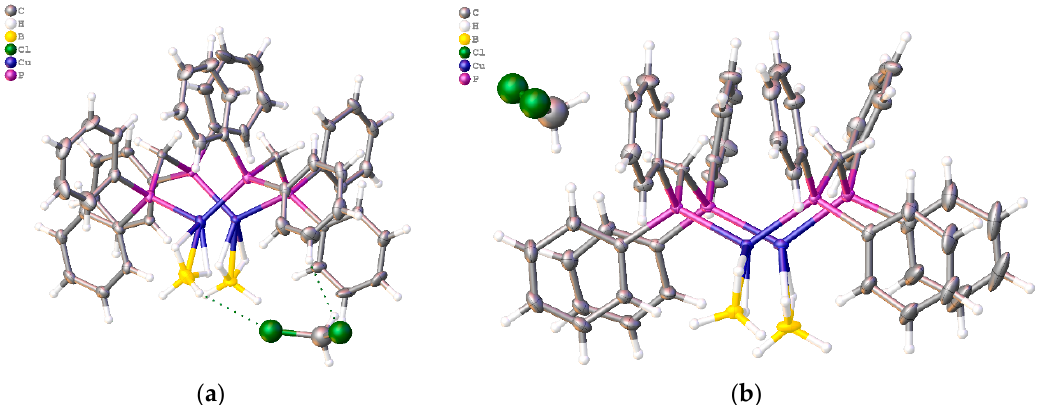
Figure 1. General view of molecular structures 1 ( a ) and 2 ( b ). Thermal ellipsoids are drawn at the 50% probability level.